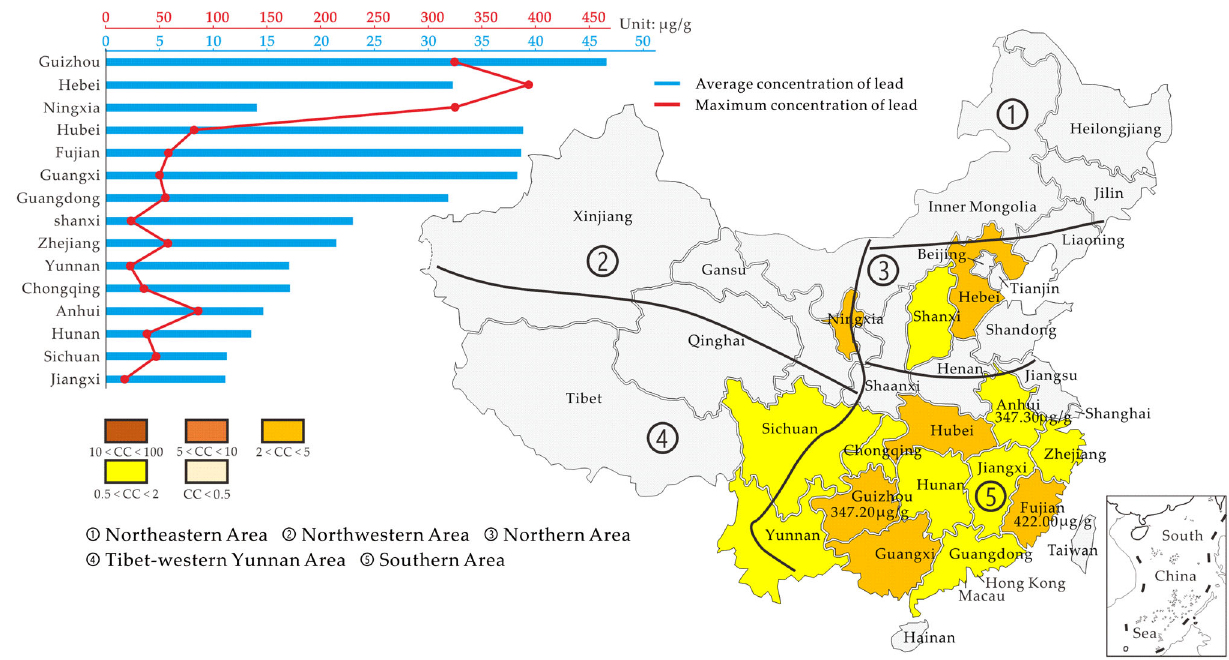
Fig. 4 Distribution of lead in Chinese coals from the Late Permian (P 2 ) period. CC: Concentration coefficient